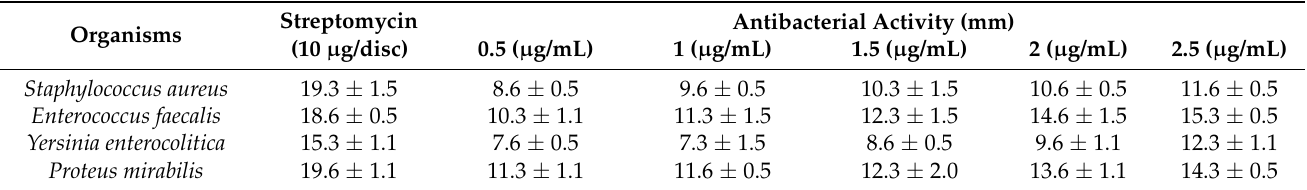
Table 3. Lethal concentrations of green synthesized Ag NPs against Gram-positive and Gram- negative bacteria.